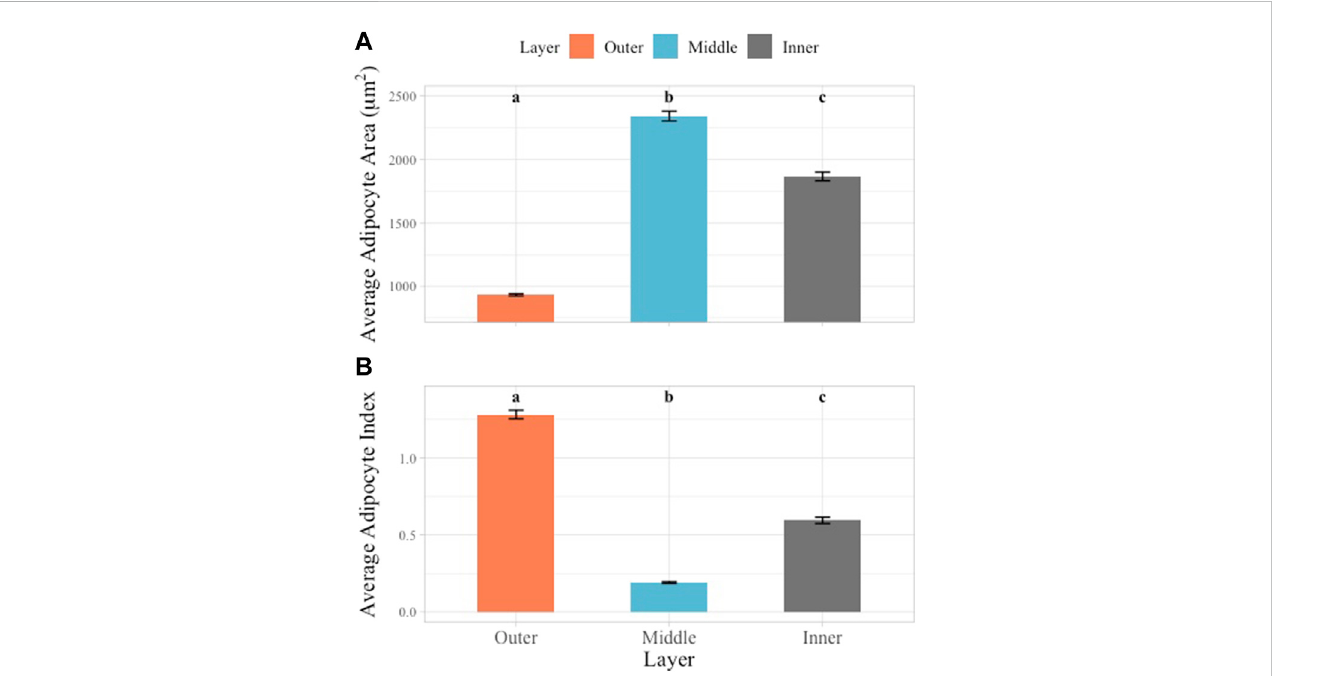
FIGURE 4 MultiplecomparisonsofaverageAAandAIacrosslayers.Blubberlayerrepresentedbyuniquecolor.Multiplecomparisonsshowedsigni fi cantdifferences between alllayersinAA (A) andAI (B) data.Signi fi cantdifferences illustrated usinglowercaseletters aboveeachbargraph. Errorbarsrepresent